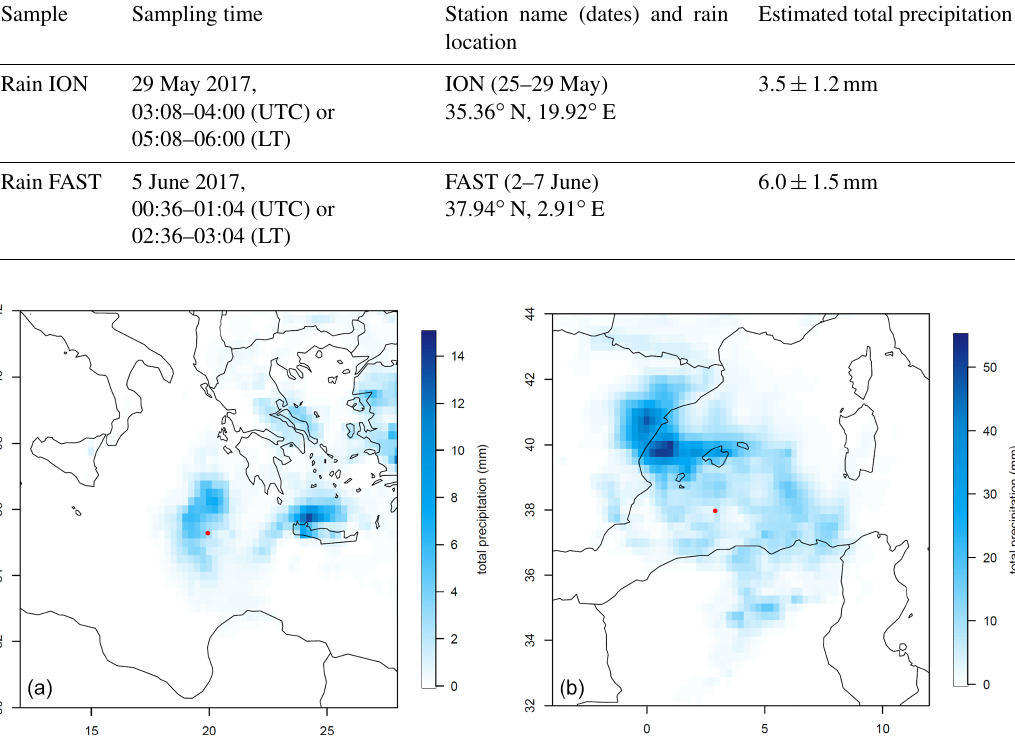
Figure 2. Total precipitation (mm) between 28 May at 20:00UTC and 29 May 2017 at 10:00UTC (Rain ION, a ) and between the 4 June at 20:00 and 5 June 2017 at 09:00UTC (Rain FAST, b ) from ERA5 ECMWF reanalysis. The red circle indicates the R/V position. Note the different scales for total